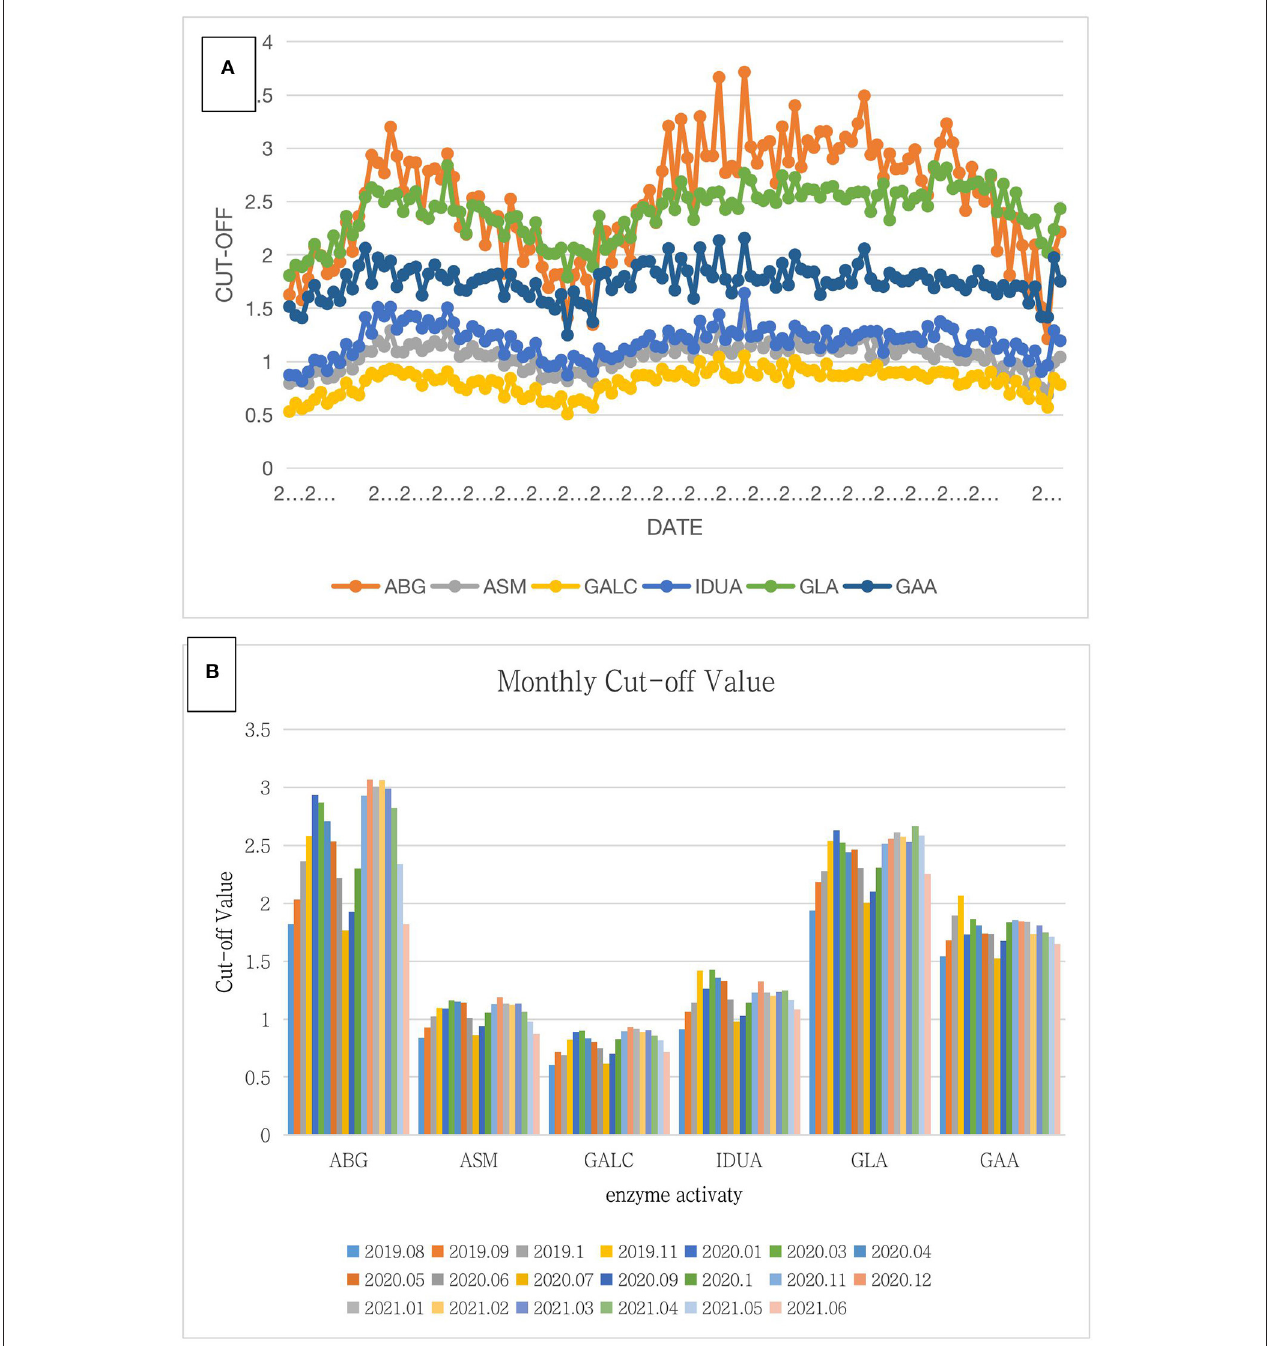
FIGURE 1 | Summary of the cutoff value for 38,945 screening samples. (A) In this chart, the abscissa is the date of the experiment, and the ordinate is the cutoff value of six lysosomal enzymes. The orange, gray, yellow, blue, green, and navy blue lines represent ABG, ASM, GALC, IDUA, GLA, and GAA, respectively. The overall trend of the six lysosomal enzymes was first an increase and then a decrease followed by another increase, finally showing a downward trend. Among them, the increasing trends of ABG and GLA were obvious though the changes in ASM, IDUA, GAA, and GALC were not significant. (B) In this chart, the abscissa is six lysosomal enzymes, and the ordinate is the average monthly cutoff value. Differently colored bars represent different months. For all six lysosomal enzymes, the average cutoff values were the lowest in July and highest in November, December, January, or February.